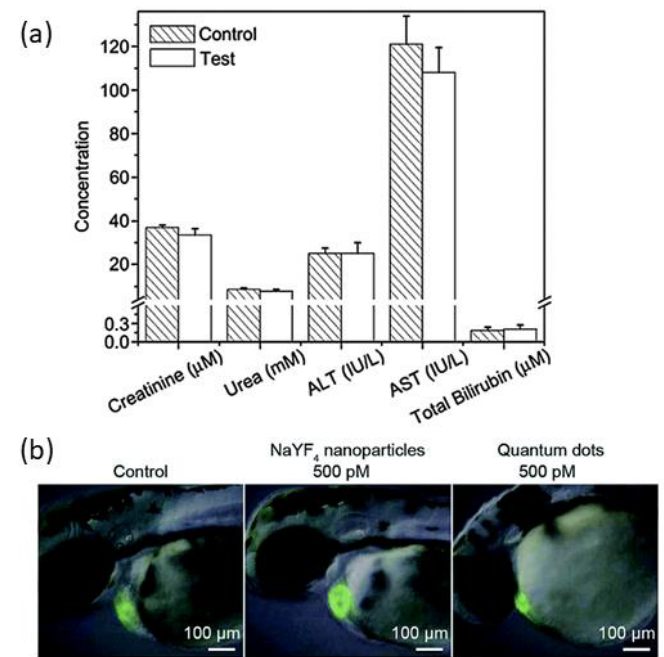
Figure 9. ( a ) Serum indicators of mice injected with PAA-conjugated NaYF 4 :Tm 3+ /Yb 3+ UCNPs and mice receiving no injection (control); and ( b ) observation of heart function and heart size of zebrafish upon treatment with quantum dots and NaYF 4 UCNPs (Figure 9a,b was reproduced from Ref. [94,97], Copyright (2010), (2014), respectively, with permission from Elsevier).